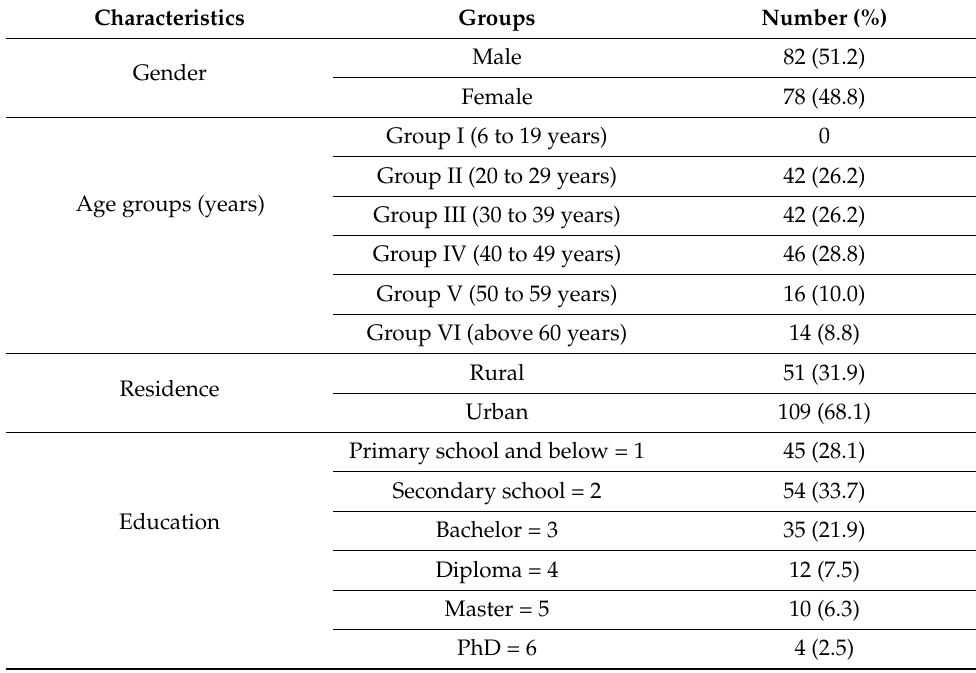
Table 1. Socio-demographic characteristics of the participants.